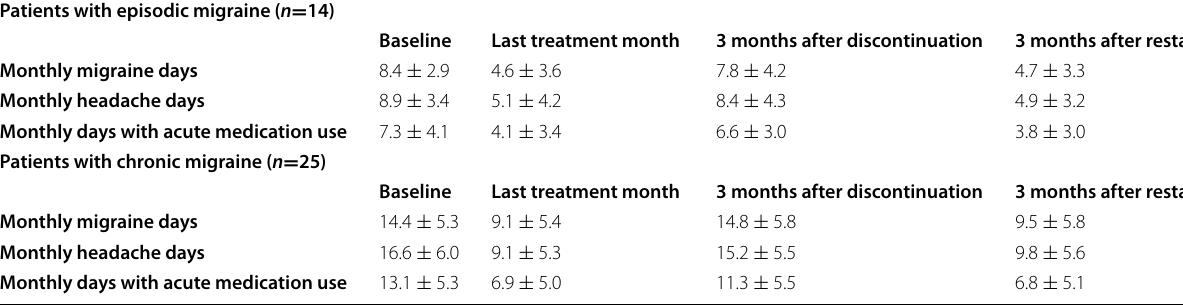
Table 3 Monthly migraine days, monthly headache days, and monthly days with acute medication use across the observation period in patients with episodic migraine and patients with chronic migraine Patients with episodic migraine ( n =